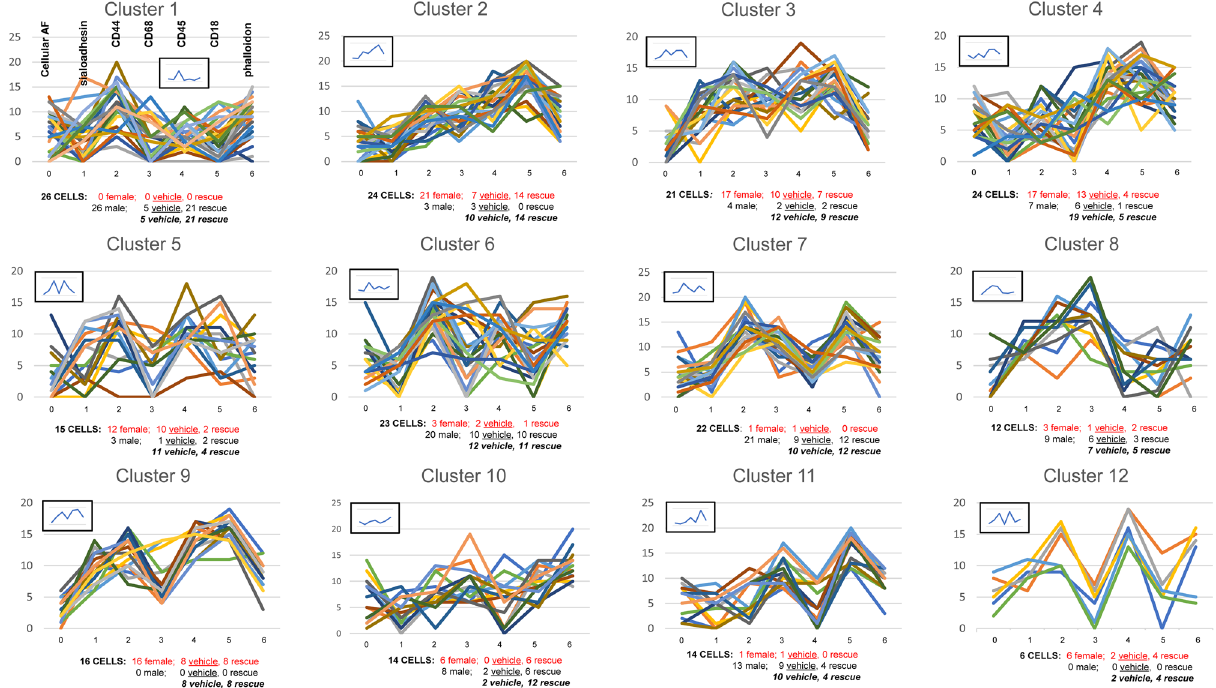
Figure 7. Graphs of sex comparison clusters. The graphs of individual cells in each cluster are shown, together with the calculated marker means graphed in the insets as in Fig. 5. The names of the proteins corresponding to each marker are given in the panel for cluster 1. Below each set of graphs the makeup of each cluster is summarized with respect to sex and experimental group (Vehicle vs. SP-A1